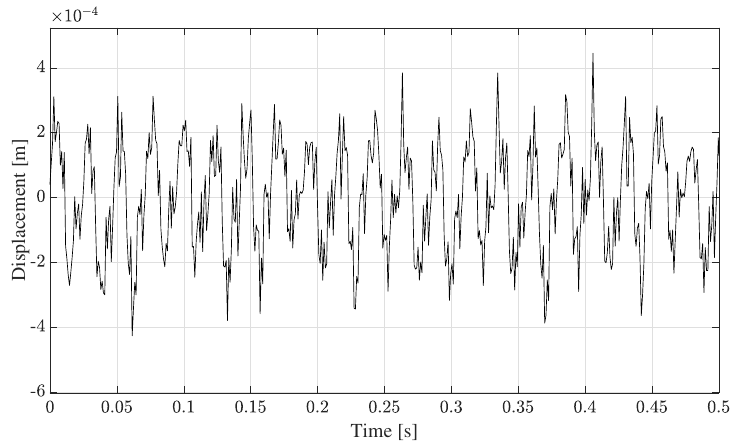
Figure 13. Displacement signal obtained from the proposed signal processing technique.